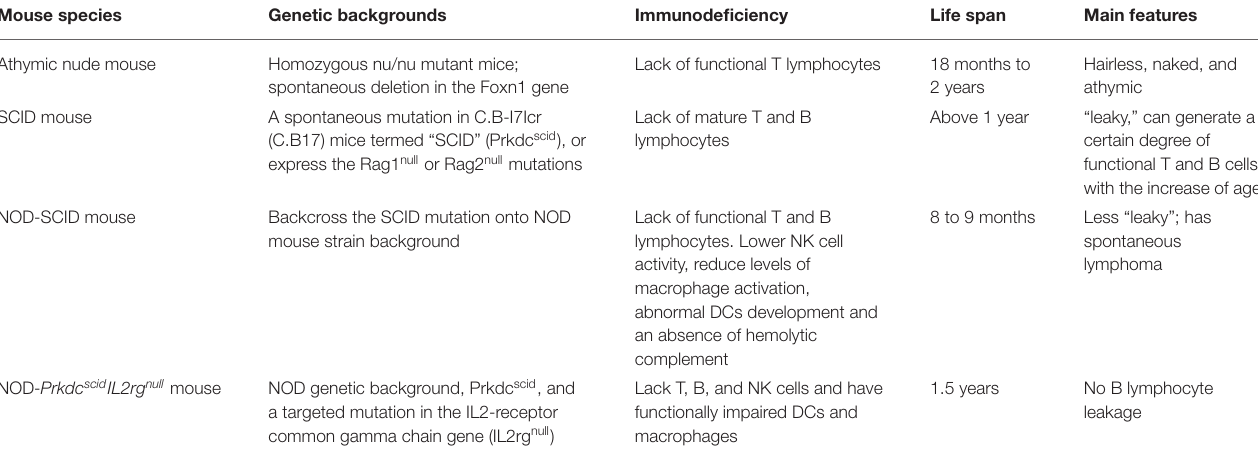
TABLE 3 | Four kinds of immune-deficient mice (118–125).